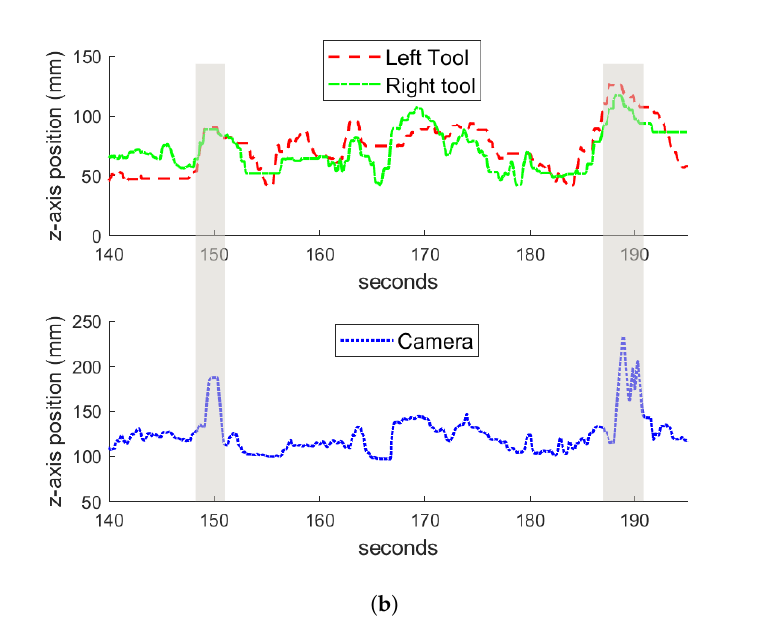
Figure 10. Zoom-out gesture during the ( a ) training and the ( b ) reproduction experiments. The shadow areas represent the moment in time in which the gesture